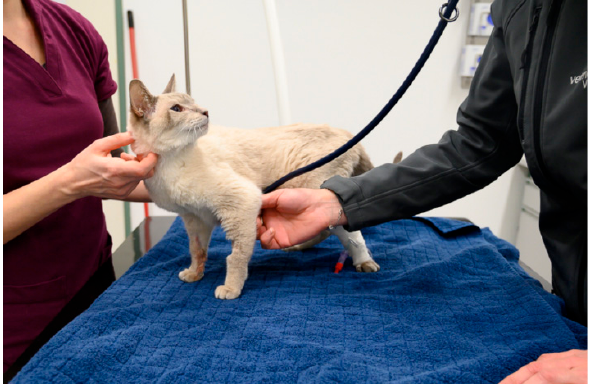
Figure 5. Performing the examination in a position that is most comfortable for the individual and using the minimal amount of fixation needed improves the patients’ compliance and well-being. Photo: Christine Arhant, Vetmeduni Vienna.